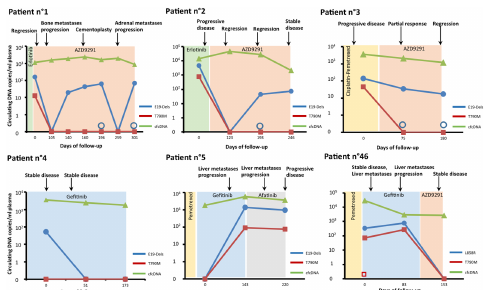
Fig 4. Monitoring of targeted sensitizing and resistance EGFR mutations and circulating cell-free DNA levels over time in 6 metastatic NSCLC patients using dPCR. Coloured regionindicatesperiodof chemotherapy. Radiological assessment of patient response is indicatedabovethe figures. Empty circles and squaresindicatessensitizingand resistancemutations positivesby dPCR but not detected by NGS